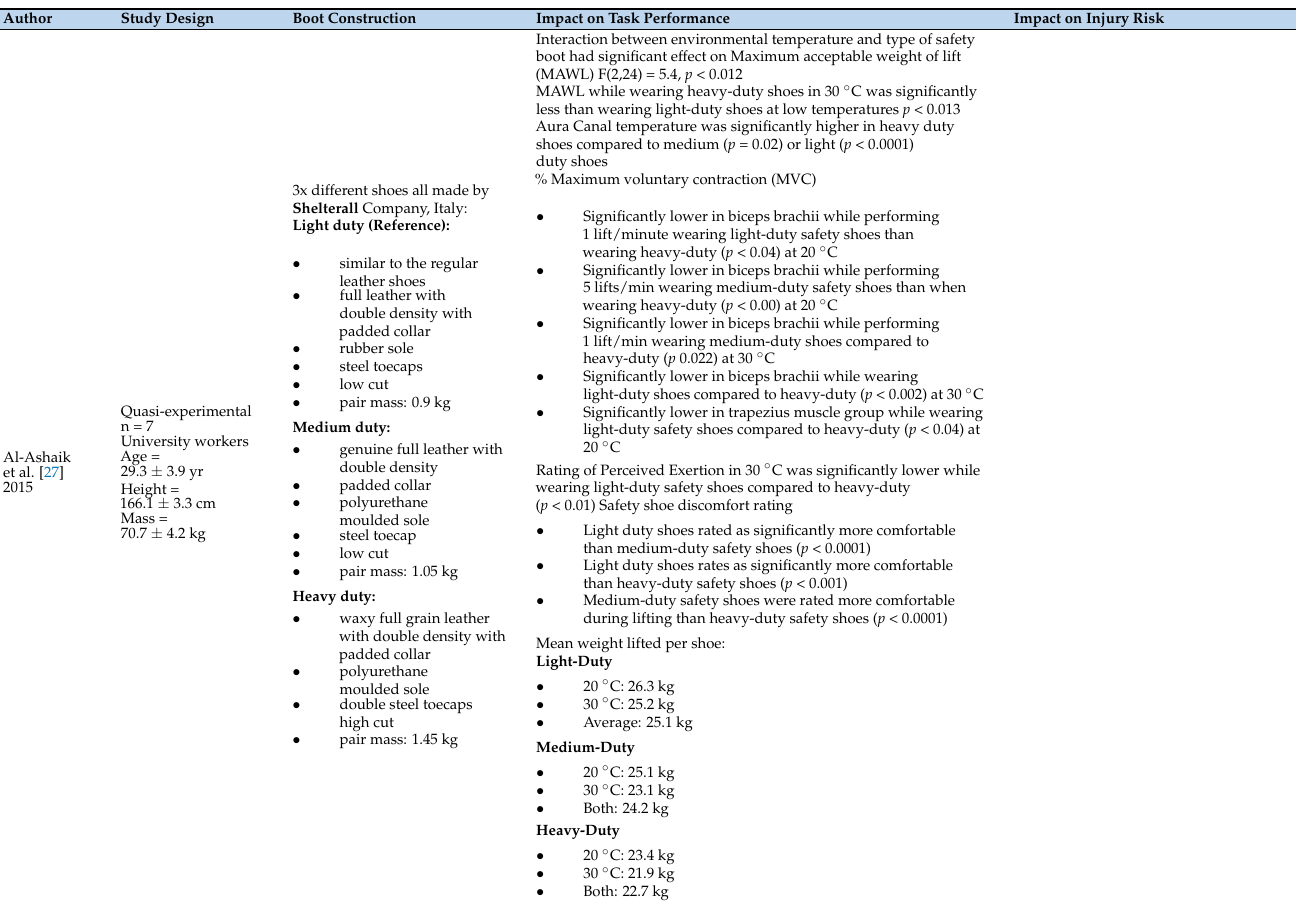
Table 3. Characteristics and key findings of studies assessing occupational footwear and impact on task performance and musculoskeletal injury